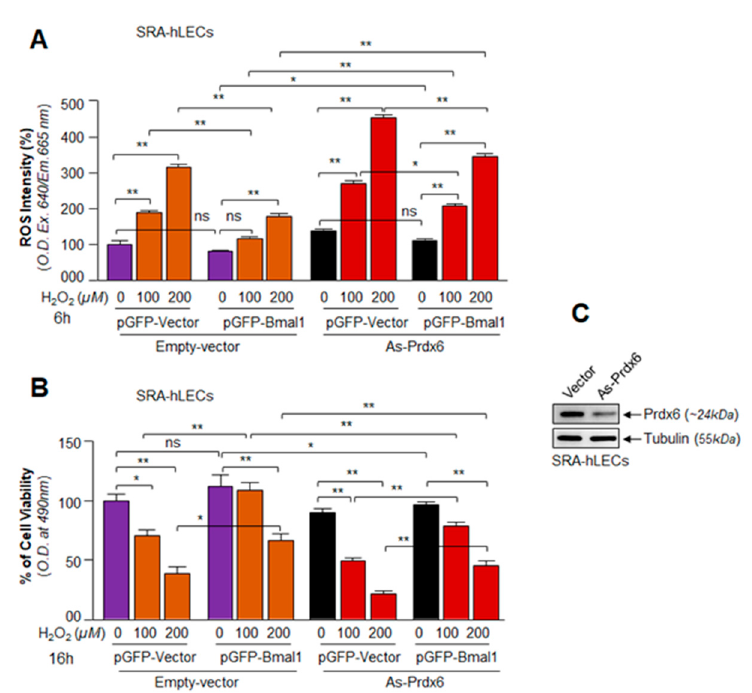
Figure 7. Cellular abundance of Prdx6 was required for significant protection of SRA-hLECs by Bmal1, and reduced abundance of Prdx6 a ff ected the protective potential of Bmal1. SRA-hLECs were transfected with Prdx6-As or empty–vector. After 48 h, cells of each group were pooled and transfected with pGFP-vector or pGFP-Bmal1 using the Neon transfection system (Invitrogen). Equal numbers of cells were harvested in 96-well plates for MTS and ROS assays to avoid the transfection e ff ect and then treated or untreated with di ff erent concentrations of H 2 O 2 as indicated. ( A ) Six hours after H 2 O 2 exposure, ROS intensity was measured using CellROX Red reagent as described in Materials and Methods. ( B ) Cell viability was measured after 16 h of H 2 O 2 exposure using MTS dye. Data represent means ± S.D. values of three independent experiments. Black bars vs. red bars; * p < 0.05, ** p < 0.001. ( C ) SRA-hLECs were transfected with antisense (As)-Prdx6 (4 µ g) or empty vector plasmid, and the e ff ect of antisense of Prdx6 (As-Prdx6) was confirmed through immunoblotting with an anti-Prdx6 antibody.